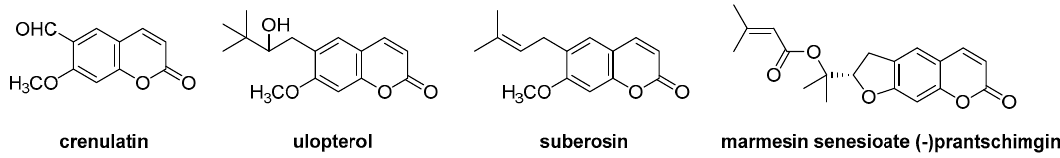
Figure 25. Coumarins from Ferulago trachycarpa .